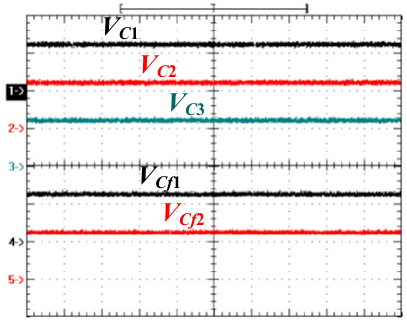
Figure 8. Measured input capacitor voltages under full load [ V C 1 ~ V Cf 2 : 200 V/div; time: 2 µs].